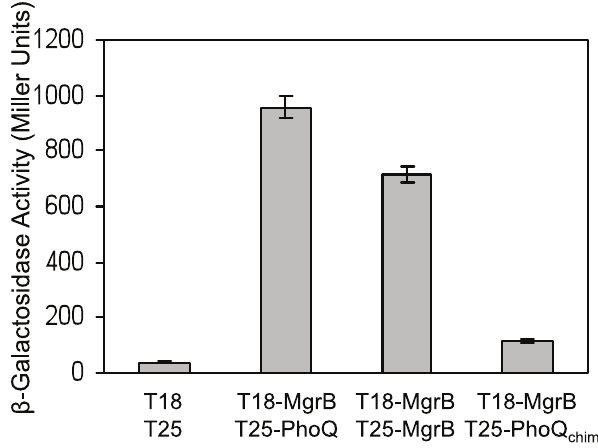
Figure 5. MgrB interacts with PhoQ and with itself. MgrB interacts with E. coli PhoQ and with itself but not with a PhoQ chimera containing a modified periplasmic domain. Cells expressed protein fusions to the T18 and T25 subunits of B. pertussis adenylyl cyclase. Reconstitution of adenylyl cyclase activity was inferred from beta- galactosidase activity. The cyaA 2 strain BTH101 contained plasmids expressing subunits alone (pKT25 or pUT18C) or subunit fusions to the N-terminus of MgrB (pAL25 and pAL33), E. coli PhoQ (pAL27), or a PhoQ chimera (PhoQ chim —pAL36). For each strain, the mean and standard deviation for three independent measurements are shown.